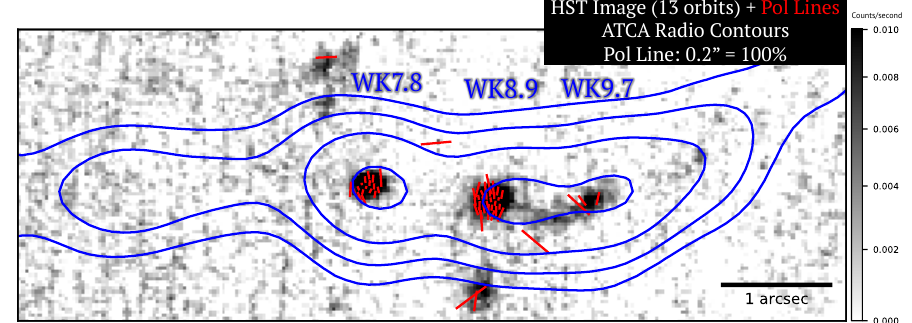
Figure 1. Optical ( HST /ACS + F606W) Stokes I image of the jet of PKS 0637–752 is shown, with radio 8.64 GHz contours from Australia Telescope Compact Array (ATCA) observations in blue and optical polarization E-vectors in red. We have filtered polarization vectors by showing only pixels with optical polarization SNR > 3.0. Polarization vectors are of scale 0.2 arcsec = 100% polarization. Radio contours increase by factors of two. Three polarized jet regions are seen, with other regions falling below the detection limit. Polarizations are as high as 31%. The greyscale is at far right. See text for details. HST Image (10 orbits) + Pol Lines MERLIN Radio Contours